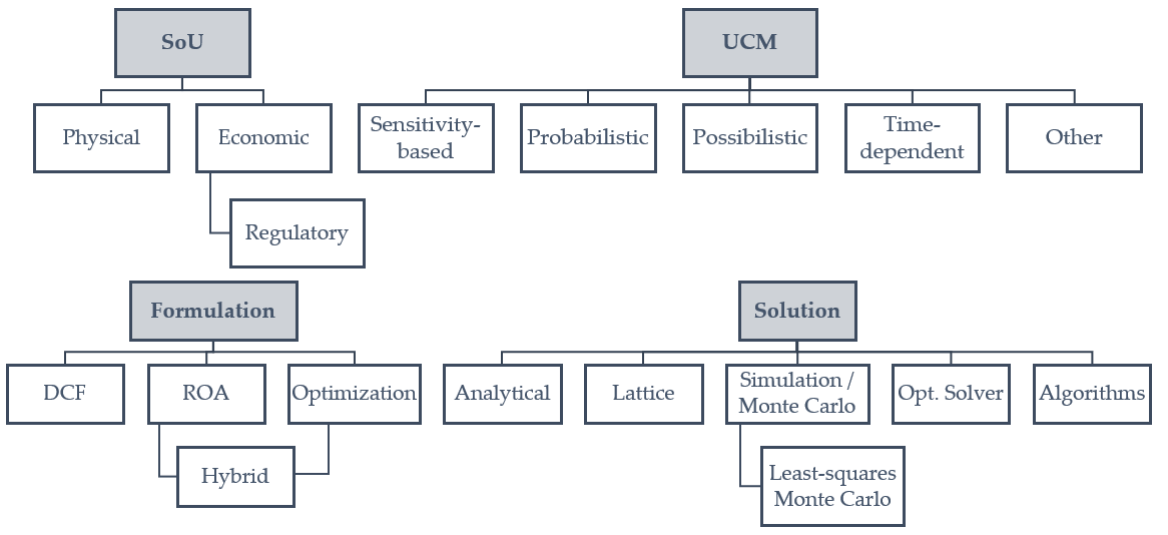
Figure 2. Classification of the articles analyzed in this review.